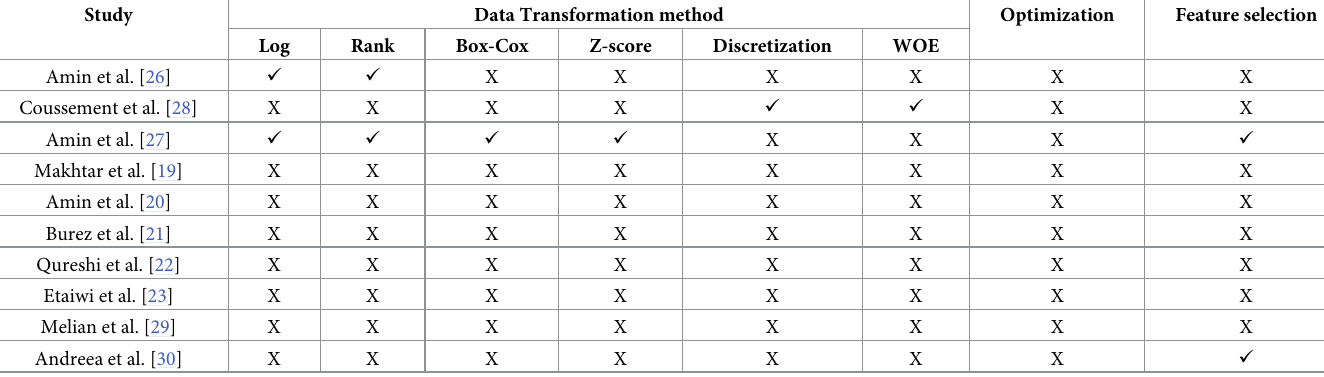
Table 1. Data transformation methods, hyperparameter optimization and feature selection used in prior